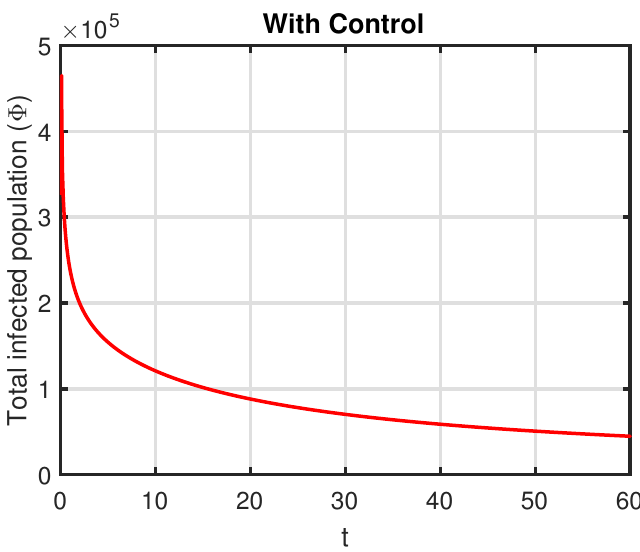
Figure 6. Time series of optimal control variables and optimal cost when combined control strategy is implemented.